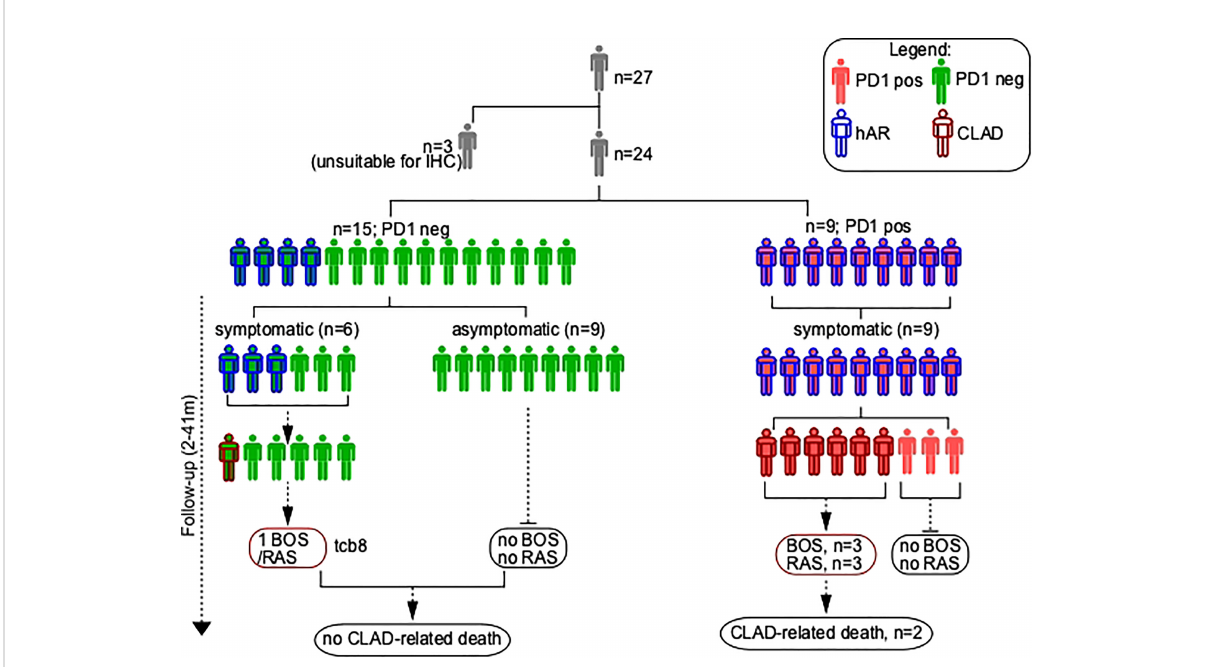
FIGURE 2 Schematic of TCB patients ’ series. hAR, Histological diagnosis of acute rejection (grade A); CLAD, chronic lung allograft dysfunction; PD1, Programmed cell death protein 1; BOS, bronchiolitis obliterans syndrome; RAS, restrictive allograft